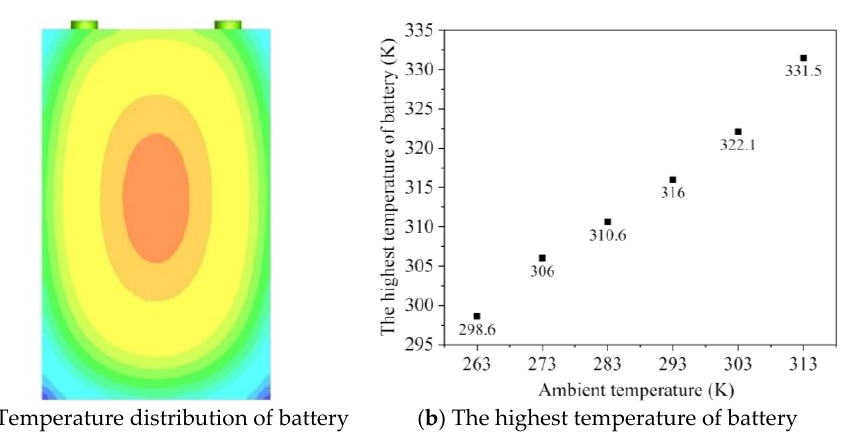
Figure 9. Simulation results in natural state at different ambient temperature.